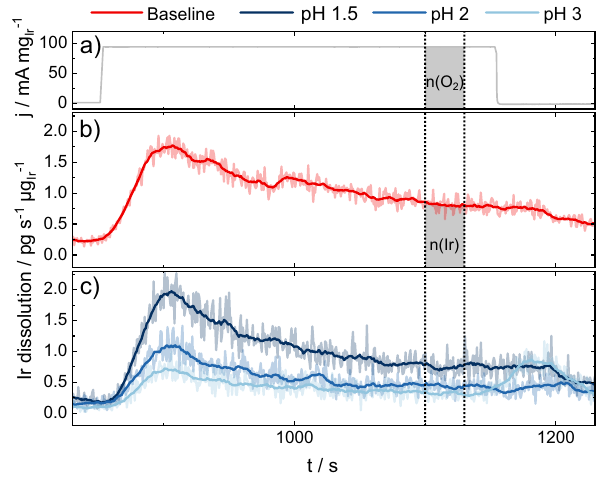
Fig. 2 Dissolution pro fi les of IrO x catalyst spots in SFC-ICP-MS measurements. a Applied current step and b , c resulting dissolution of b a baseline measurement at standard conditions (10 µ g Ir cm − 2 catalyst loading, 200 µ lmin − 1 fl ow rate, fresh electrolyte, 33wt% Na fi on in the catalyst layer and 0.1M H 2 SO 4 (pH = 1)) and c with a variation of electrolyte pH. The integration area for the calculation of S-numbers is highlighted by vertical dashed lines. Source data are provided in the source data fi